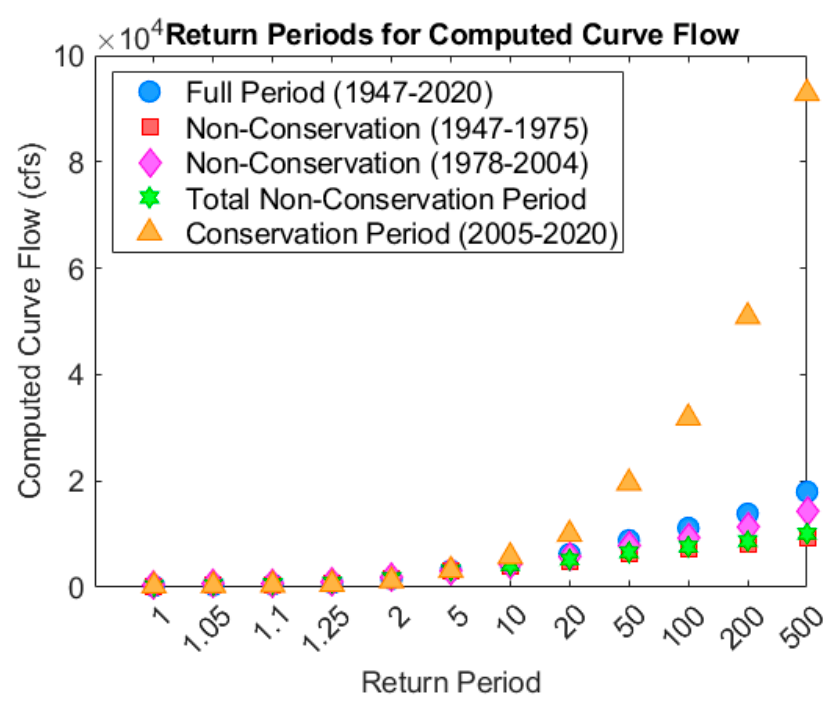
Figure A4. Flood frequency analysis results for 5 different time periods: The full period (1947–2020), the total non-conservation period (1947–1975), the first half of the non-conservation period (1947–1975), the second half of the non-conservation period (1978–2004), and the conservation period (2005-2020). Peak flow data was missing for the years 1976 and 1977, accounting for the break between the two non-conservation time periods. Table A1. Return periods and their corresponding computed curve flows for the full time period, total pre ‐ planning period, and the post ‐ planning period.